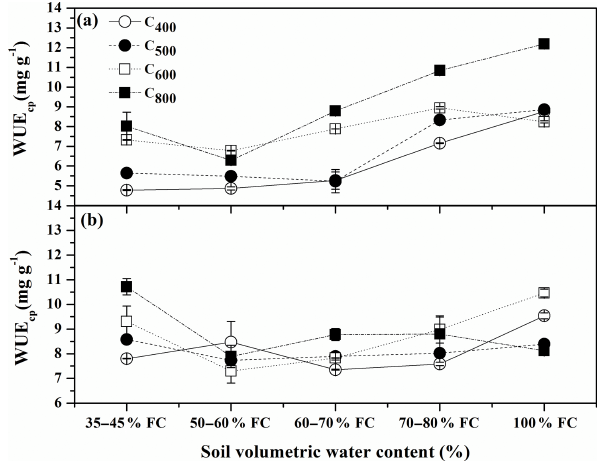
Figure 5. Instantaneous water use efficiency estimated by δ 13 C of water-soluble compounds (WUE cp ) from leaves of P. orientalis (a) and Q. variabilis (b) for four CO 2 concentration × five soil volu- metric water content treatments. Means ± SDs, n =